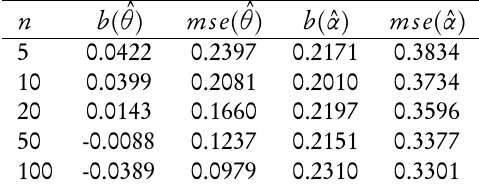
Bias and mean square error of the m.l.e.’s ( ˆ θ , ˆ α ) , for the power Poisson distribution { r